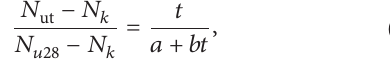
Figure 1: Stress strain relations of concrete at different